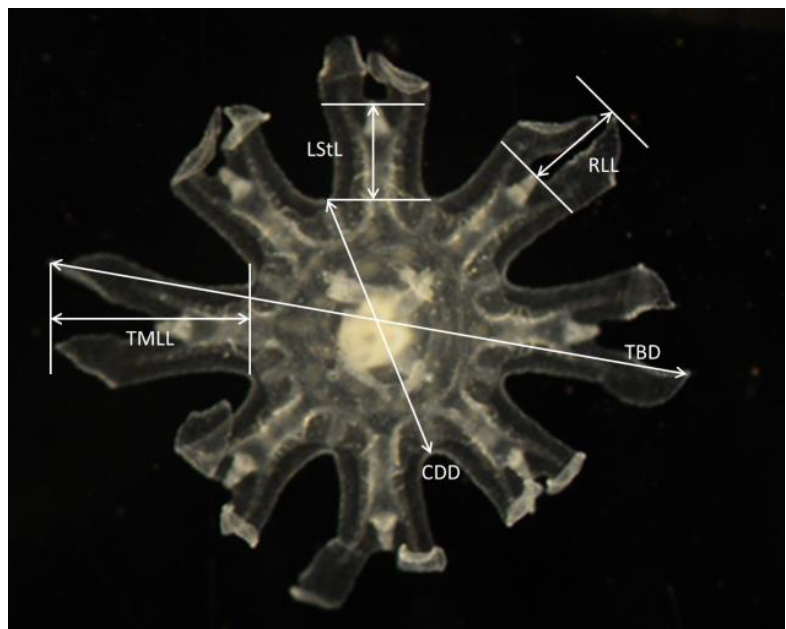
Figure 2. Ephyrae of Stomolophus sp. 2, and measurements taken following Straehler-Pohl and Jarms [27] and Straehler-Pohl et al. [37].